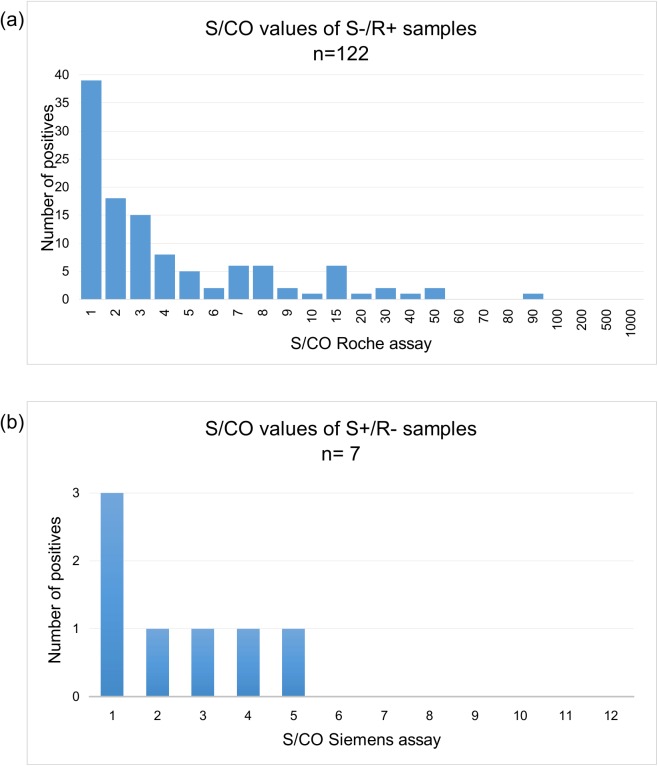
S/CO values of the positive test in S+/R- and S-/R+ discordant samples were generally close to the cut-off (weakly reactive).(a) S-/R+ samples had S/CO values between 1.0 and 99.1. (The positive range of Roche assay is 1->1000); (b) S+/R- samples had S/CO values between 1.1 and 5.8 (the positive range of Siemens assay is 1->12).